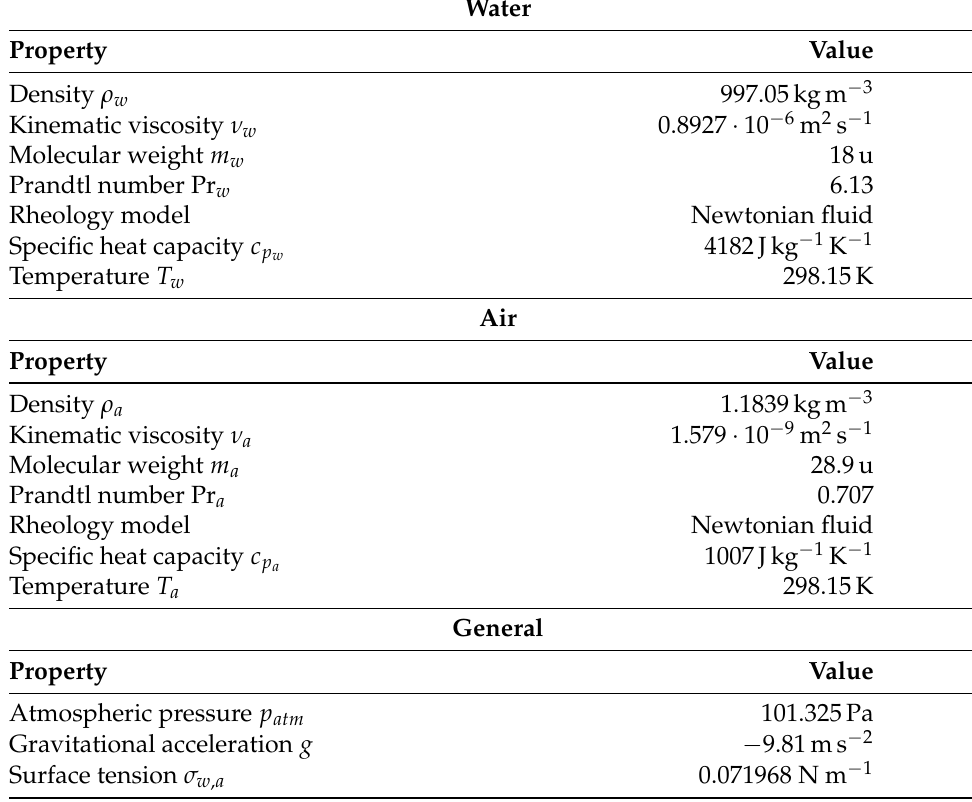
Table 1. Physical properties for all CFD simulations based on